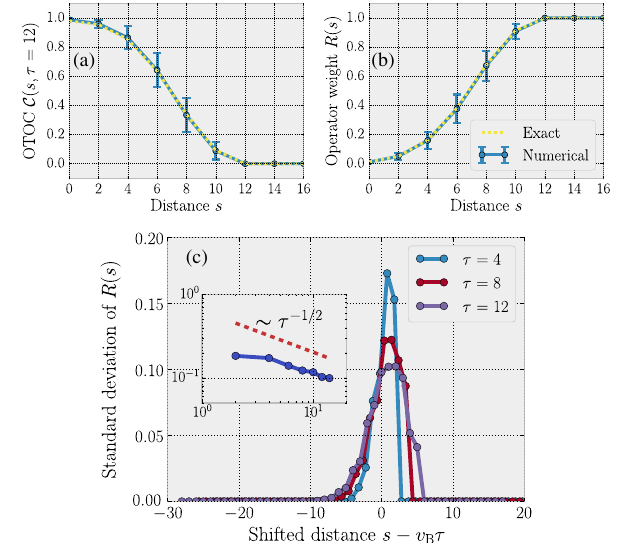
FIG. 4. Average values and fluctuations of the (a) OTOC and (b) the total weight to the left of site s for the time-evolved operator Z 0 ð τ Þ after τ ¼ 12 layers of the random circuit. Blue dots correspond to average values of 100 different random circuits, while the error bars signify 1 standard deviation. Panel (c) shows the standard deviations of R ð s Þ for different times. The largest fluctuations decrease in time approximately as ∝ τ − 1 = 2 , as shown by the